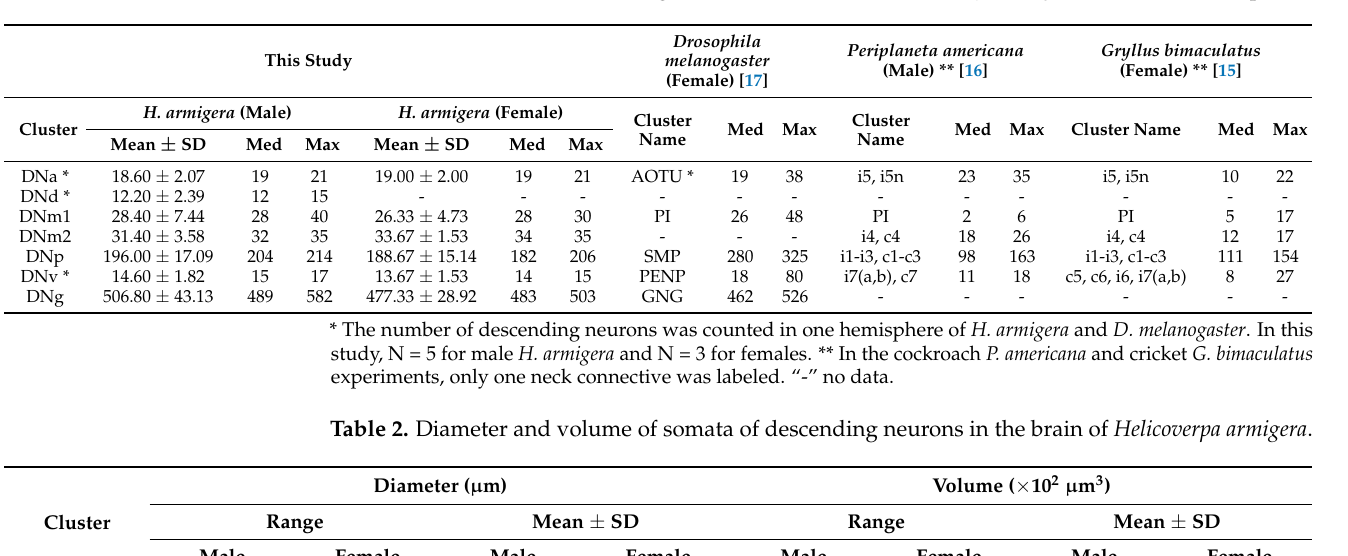
Table 1. The number of descending neurons in the brain of Helicoverpa armigera and other insect species.